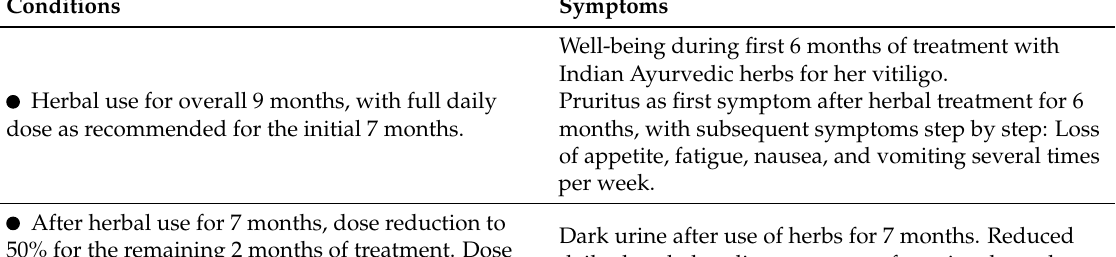
Table 4. Typical follow-up of symptoms in a case of HILI by Indian Ayurvedic herbs.